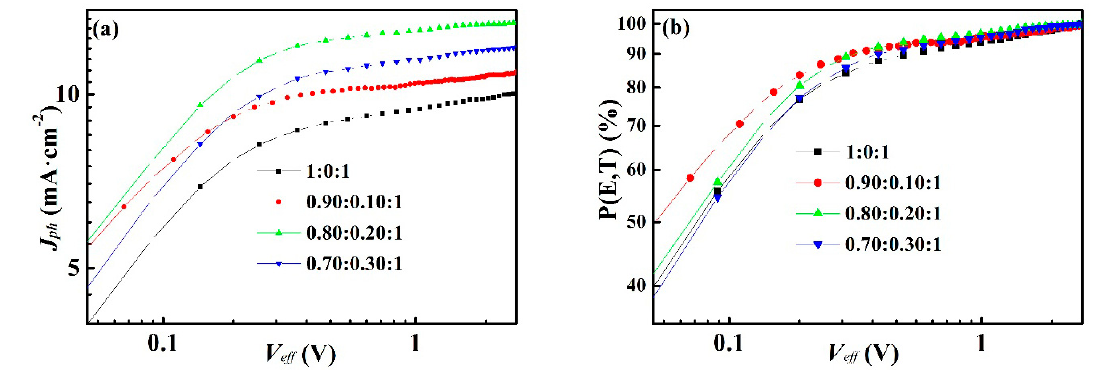
Figure 5. ( a ) The J ph − V eff curves and ( b ) P ( E , T ) -V eff curves of the OPVs with different PTT-DTNT-DT doping concentration.